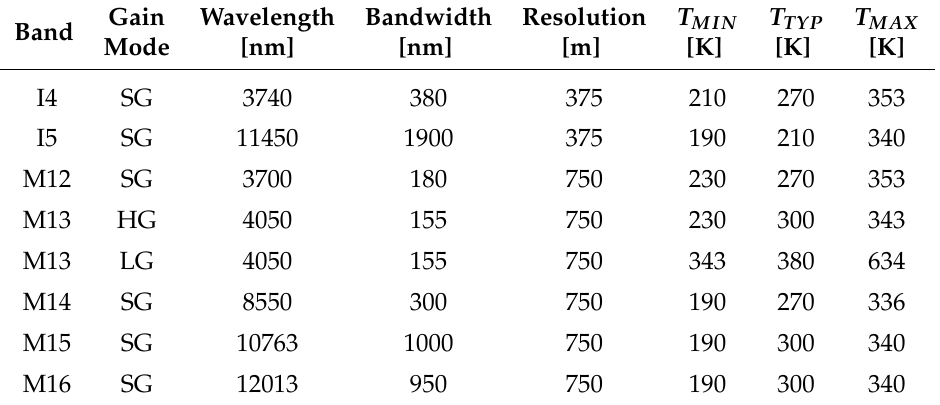
Table 1. VIIRS thermal bands with center wavelengths, bandwidths, gain mode, spatial resolution at nadir, upper and lower dynamic range limits, and typical scene temperature as defined by the sensor specification [8]. SG, HG, and LG refer to single gain, high gain, and low gain,